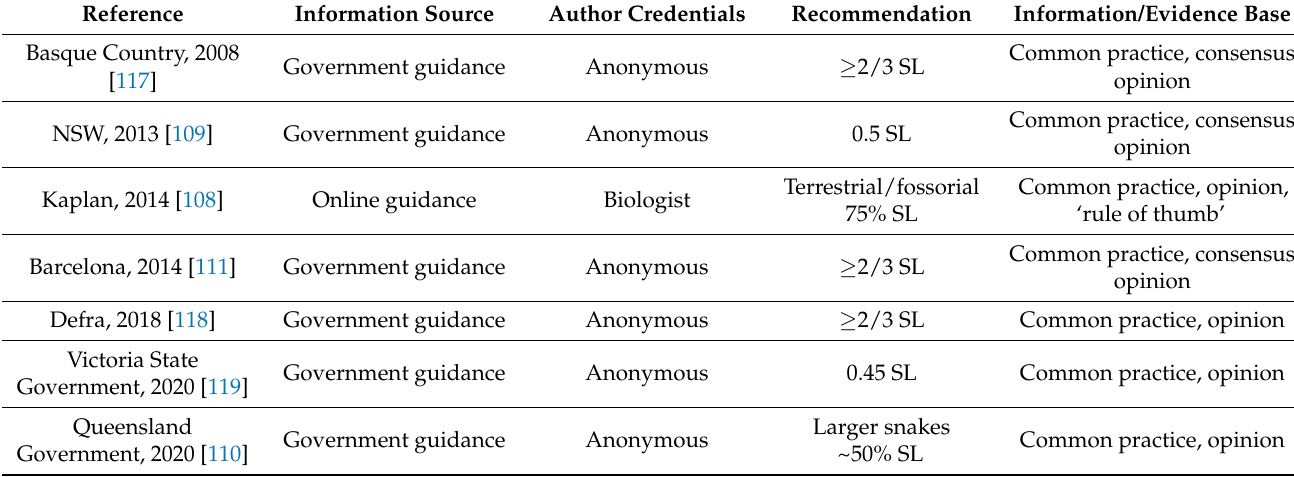
Table 6. Summary of findings from grey literature * for information sources and recommendations consistent with or specifying < 1 × snake length (SL) minimum enclosure